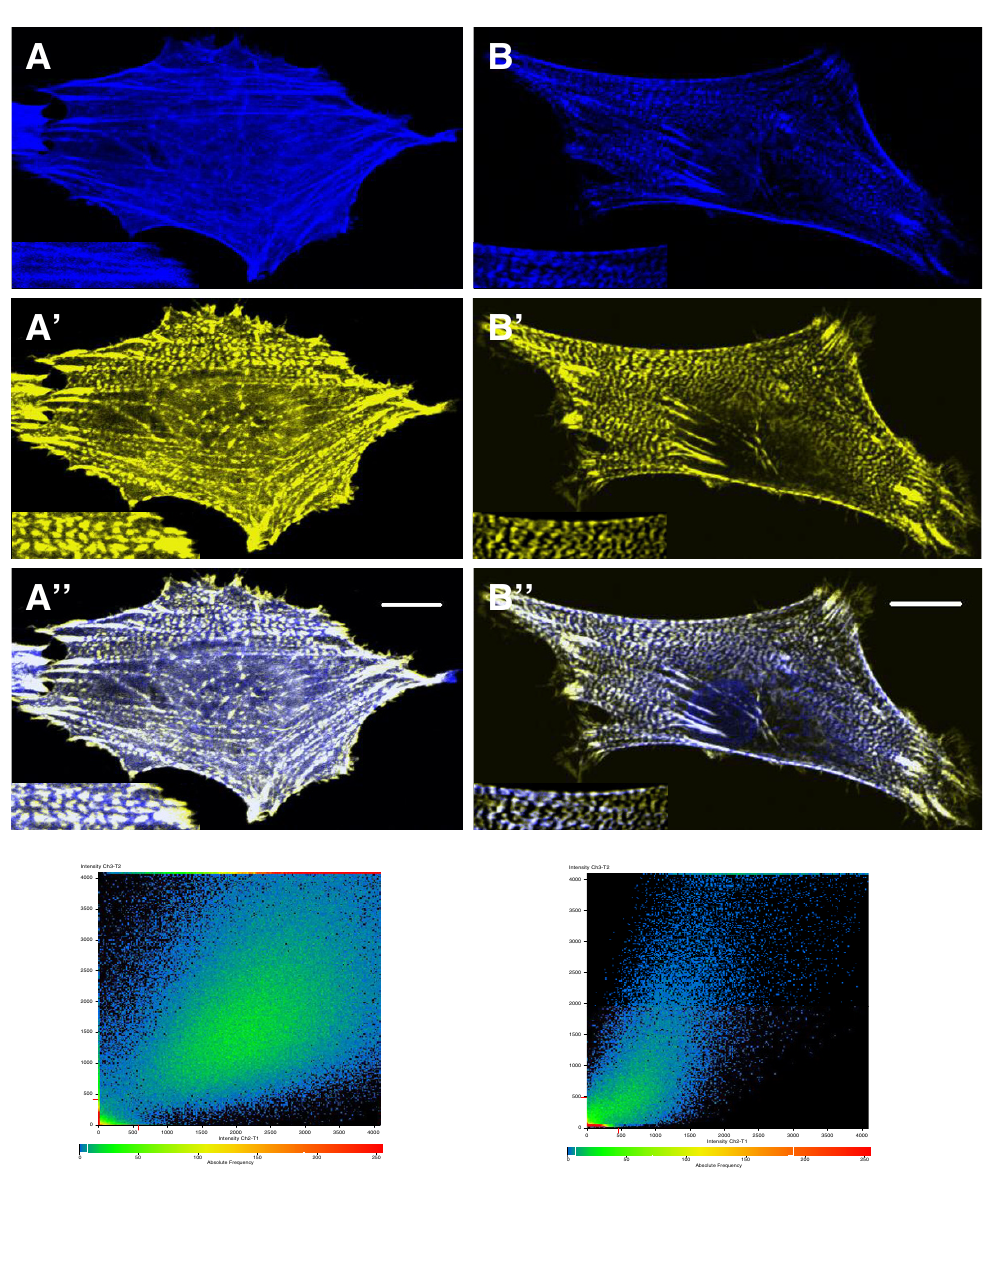
Figure 5 Two populations of CRP1 are localized along stress fibers . REFs expressing CFP-CRP1 and YFP- α -actinin were fixed with 3% formaldehyde in PBS ( A ) or Triton X-100 buffer ( B ) and prepared for confocal microscopy as described in Experimen- tal Procedures. Images of CFP-CRP1 ( A and B ) and YFP- α -actinin ( A' and B' ) localization are shown. A zoomed region is shown in the lower left corner of each image. Merged images are shown in A" and B" . Results are representative of 4 separate experiments. Bar = 10 µ